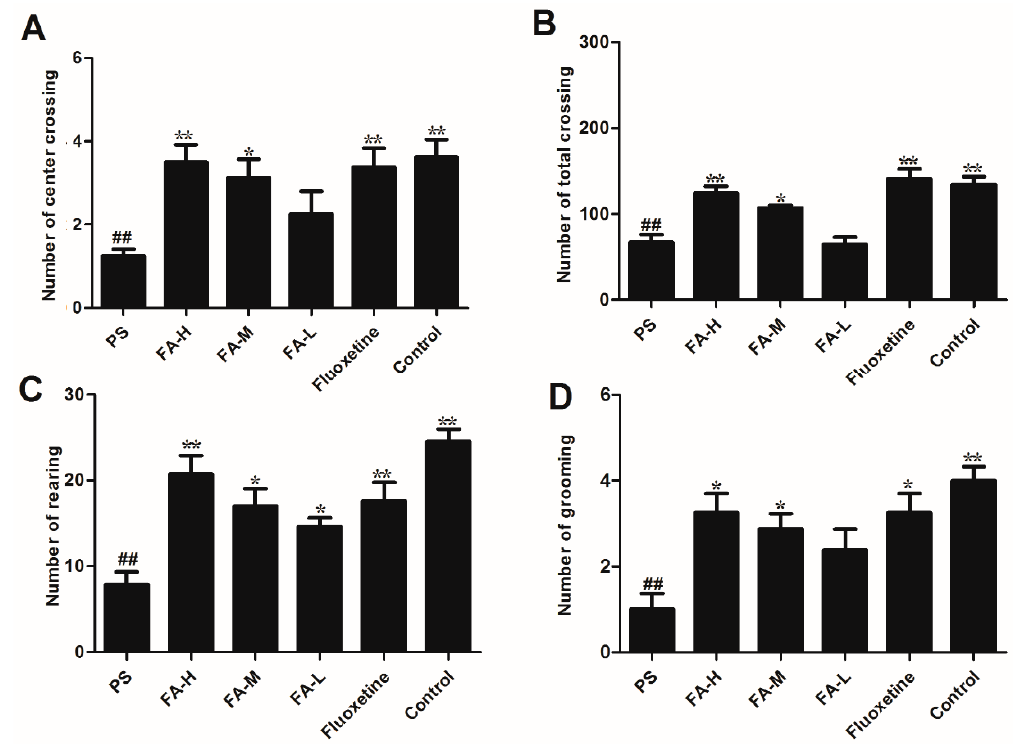
Figure 3. Effects of ferulic acid (FA) on the open field test of offspring rats exposed to prenatal stress. ( A ) The number of total crossings. ( B ) The number of center crossings. ( C ) The number of rearing. ( D ) The number of grooming. Values represent means ± SEM ( n = 8). * p < 0.05 and ** p < 0.01 compared with PS group, ## p < 0.01 compared with Control group. FA-L: FA at low 12.5 mg/kg/day, FA-M: FA at medium 25 mg/kg/day, FA-H: FA at high 50 mg/kg/day; Flx: fluoxetine.